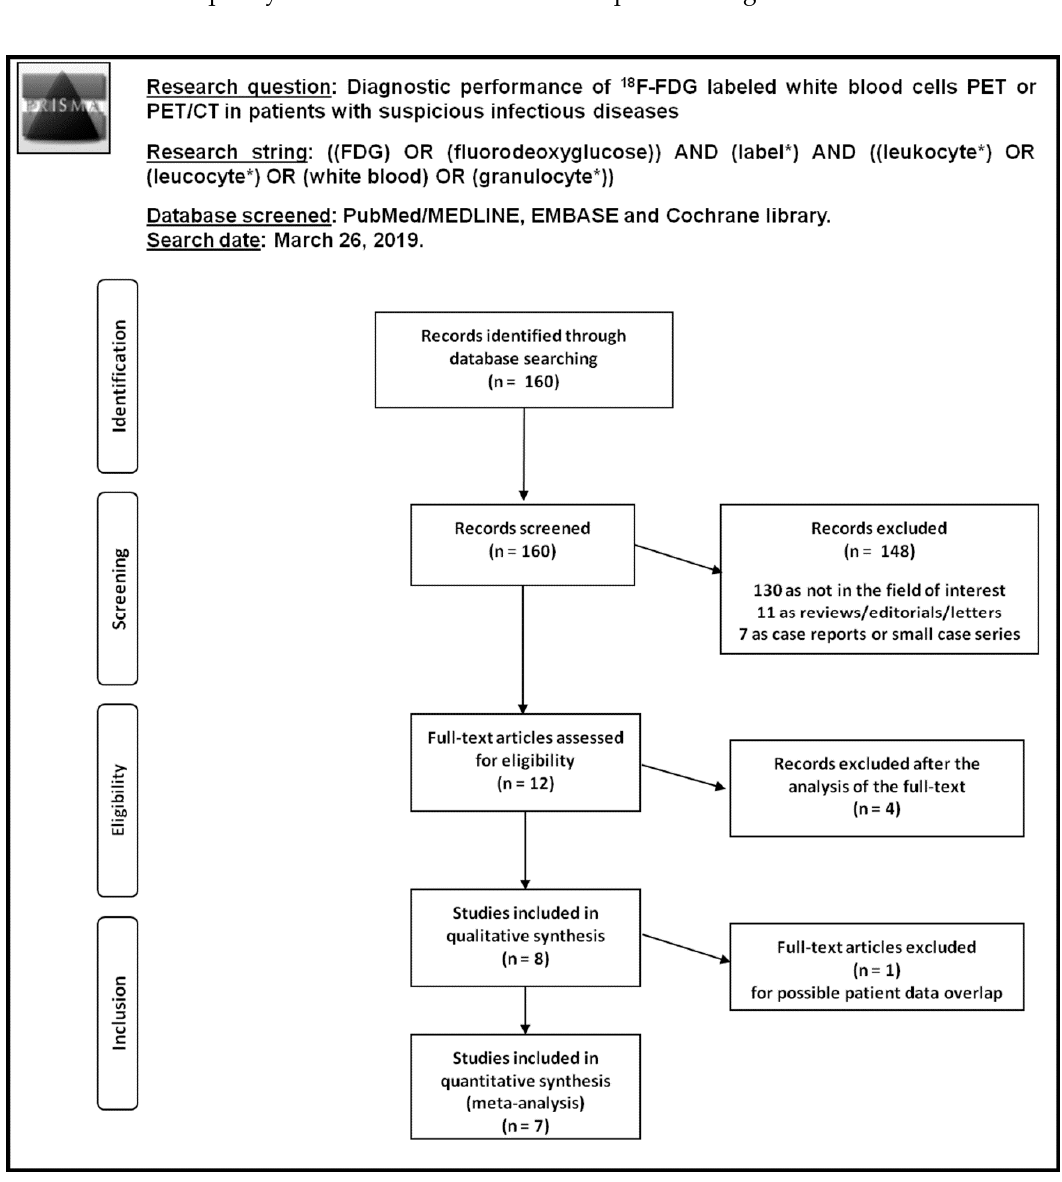
Figure 1. Flow chart of the search for eligible studies on the diagnostic performance of fluorine-18-fluorodeoxyglucose ( 18 F-FDG-WBC PET or PET/CT) in patients with suspicious infectious diseases.